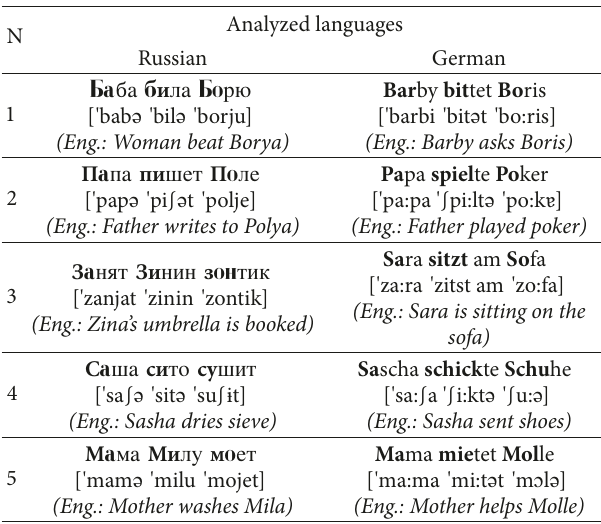
Table 1: Test phrases for experiment. Analyzed N